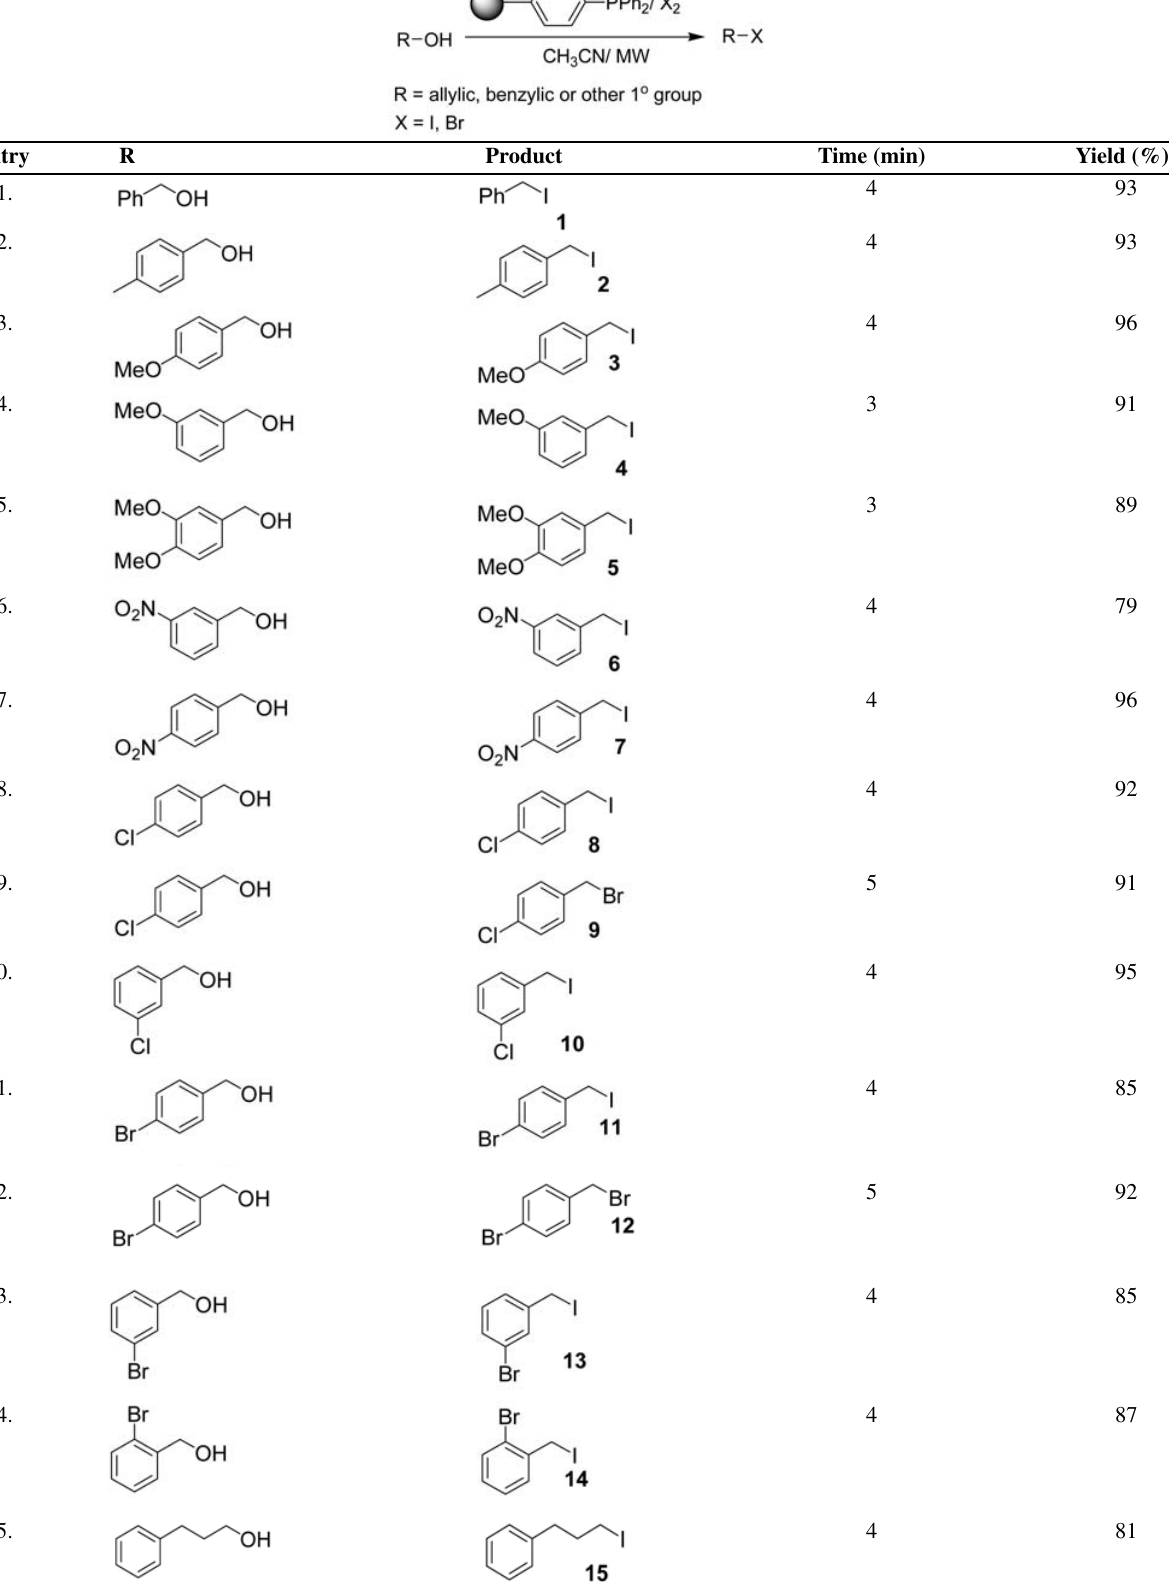
Table 1. Microwave-assisted conversion of alcohols to halides